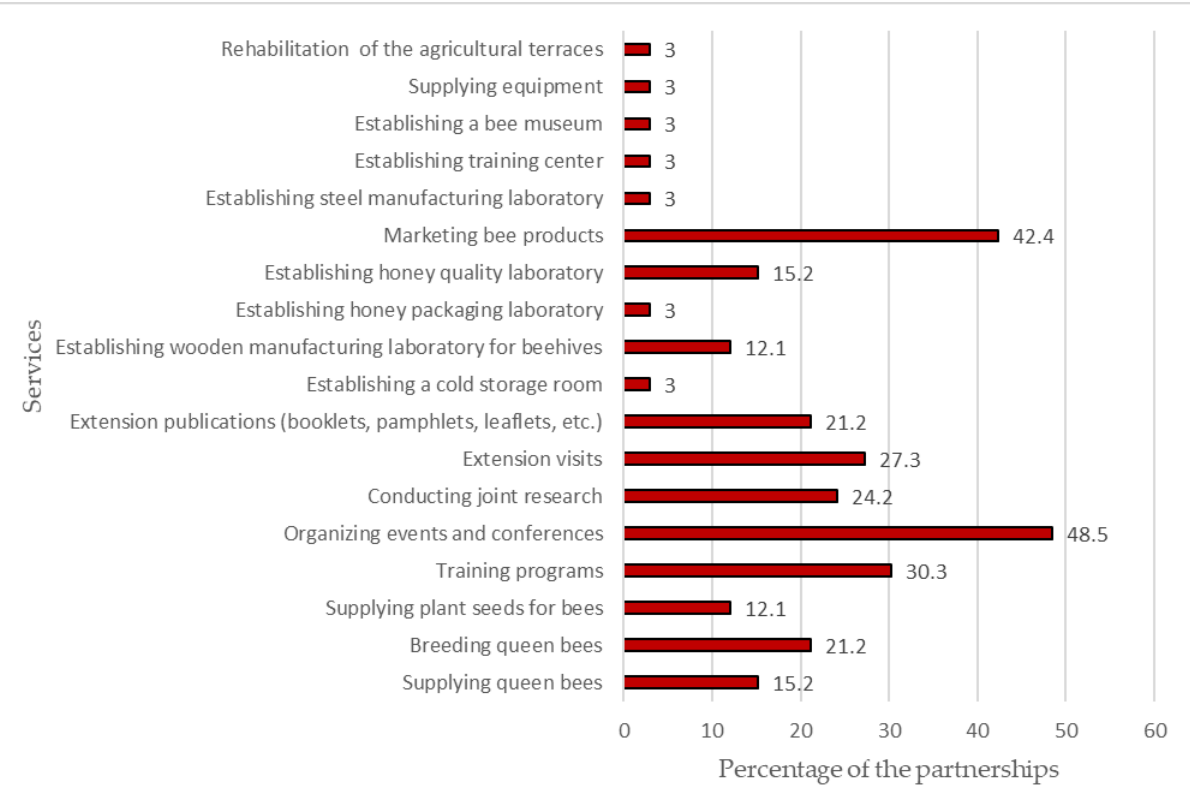
Figure 3. Services provided by the